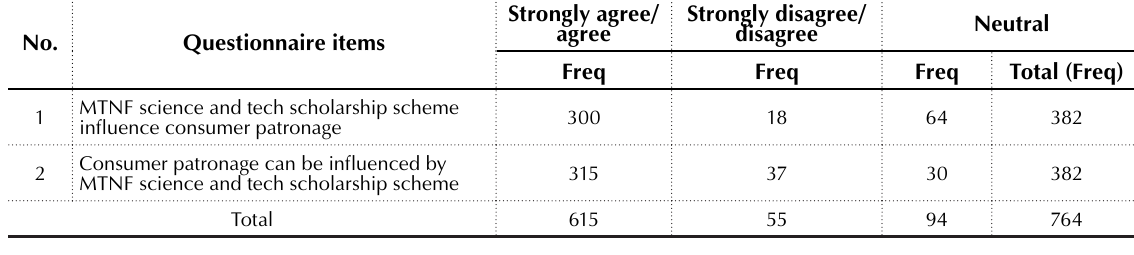
Table 1. Coded responses on the influence of MTNF science and technology scholarship scheme as a corporate social responsibility strategy on consumer patronage of MTN telecom services provider